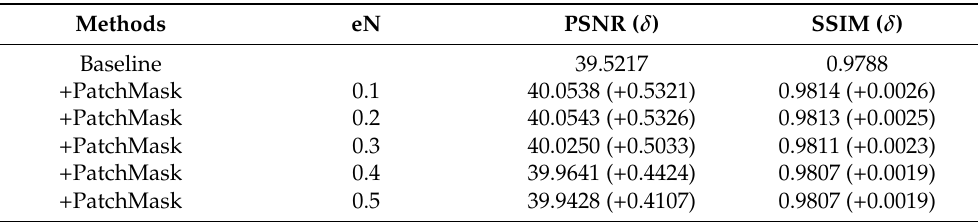
Table 6. The effect of the patch-exchange ratio on the network